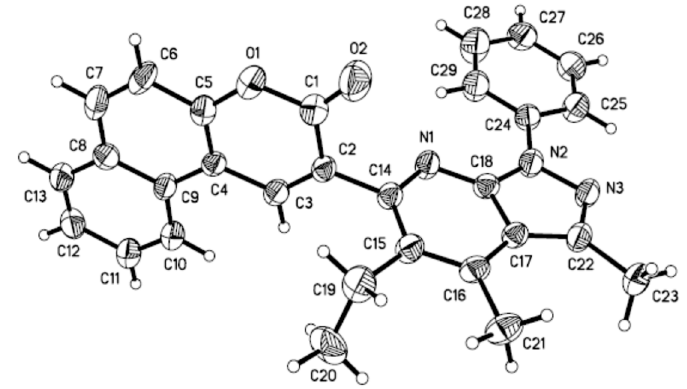
Scheme 2. New multicomponent domino reactions.